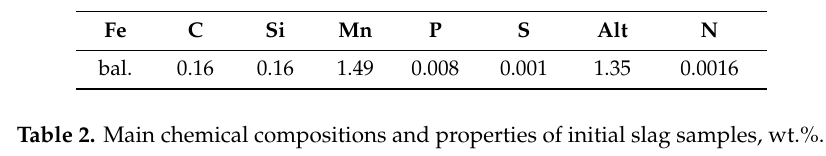
Table 2. Main chemical compositions and properties of initial slag samples, wt.%.